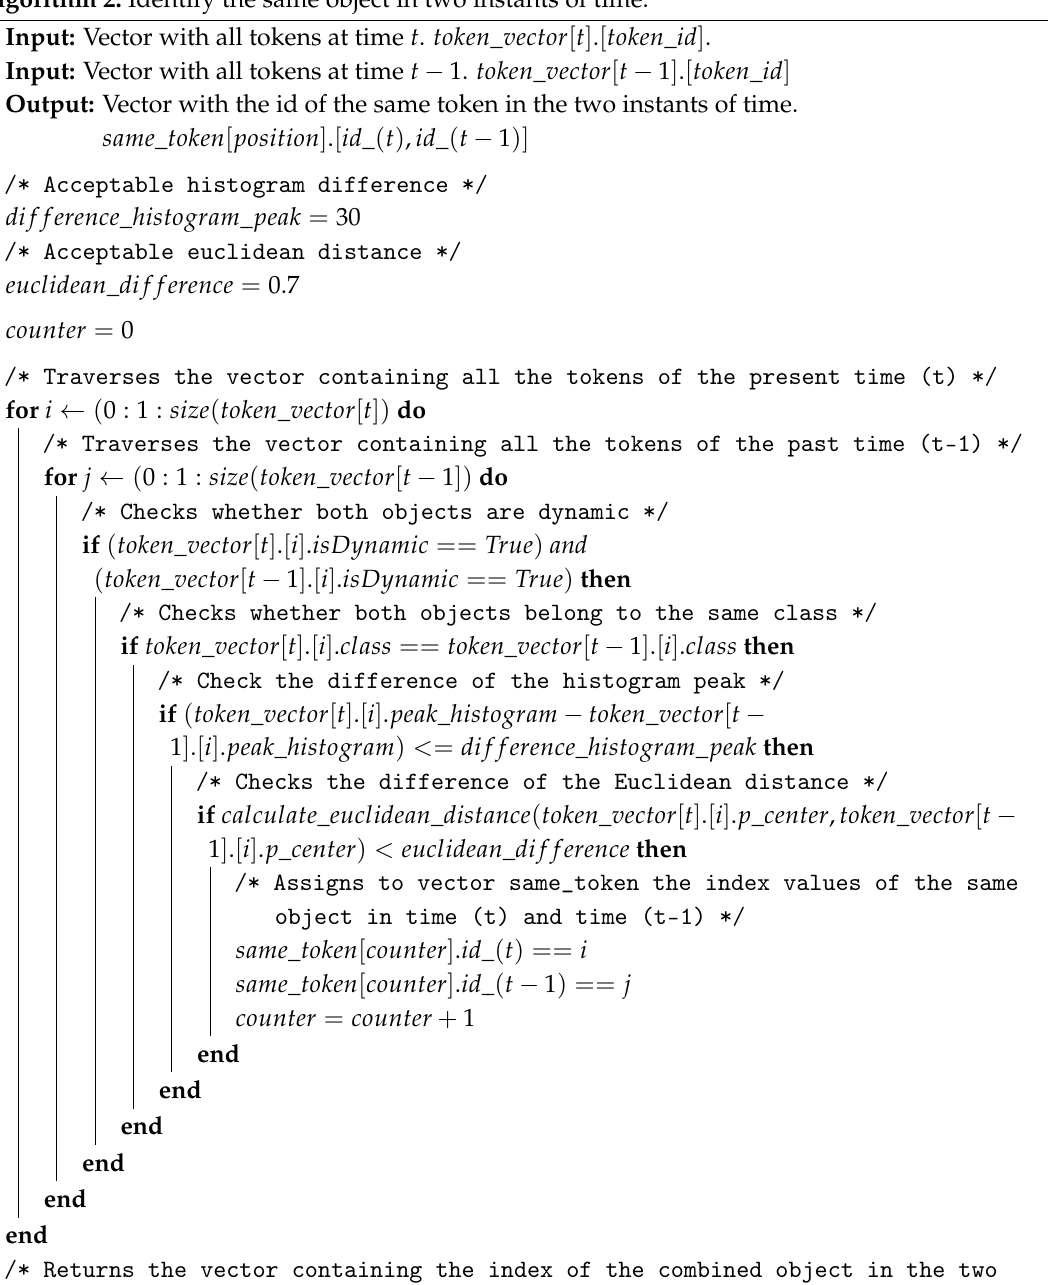
Algorithm 2: Identify the same object in two instants of